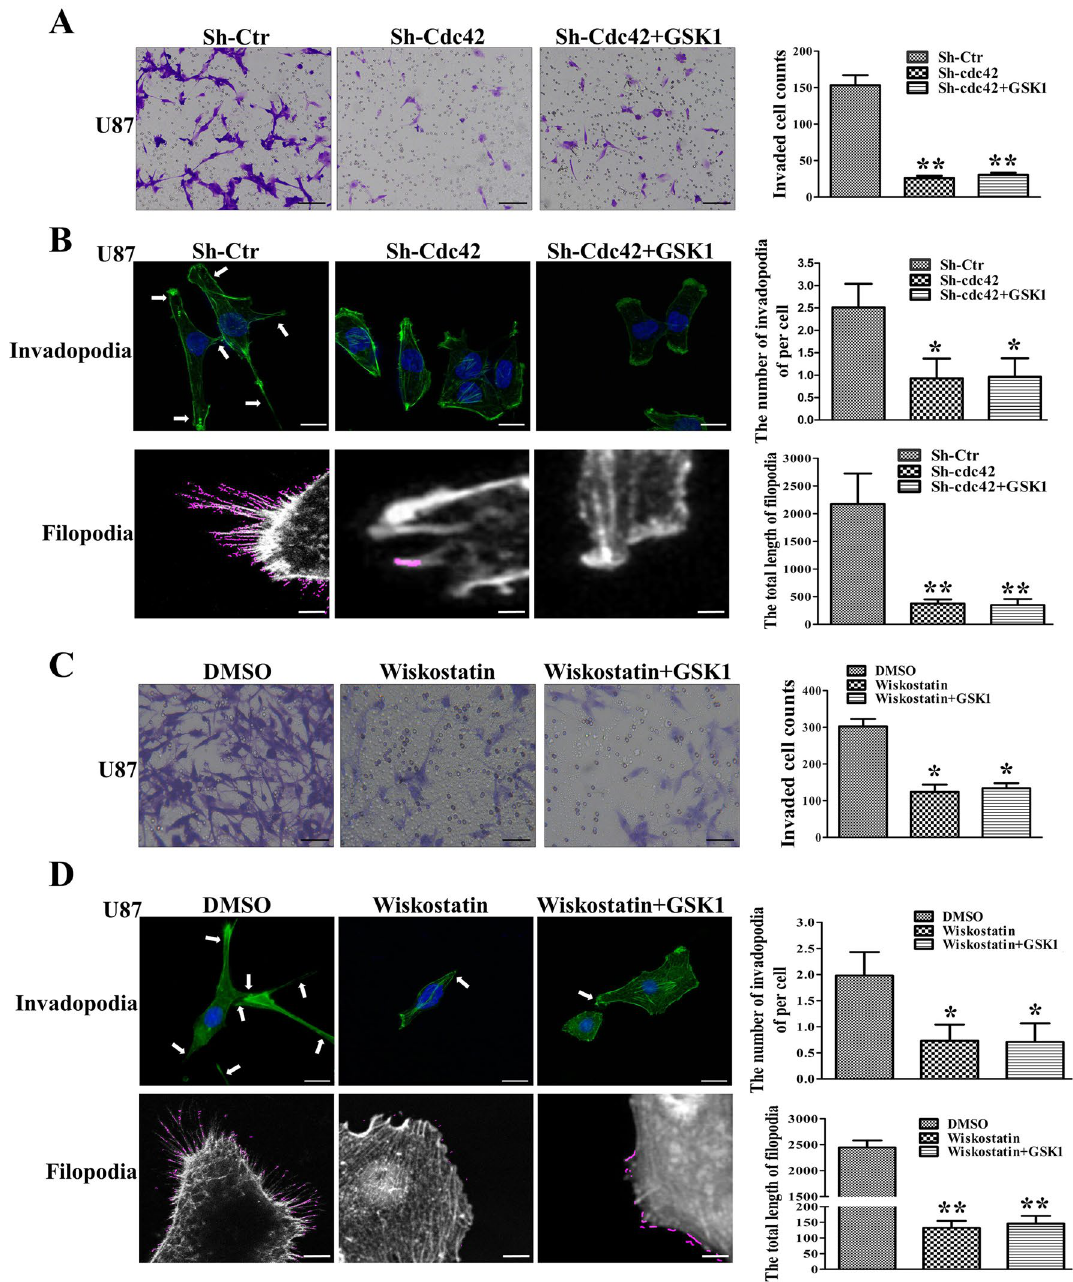
with TRPV4 agonist treatment in U87 cells, scale bar = 100 µm. ( B ) U87 cell invasion ability was detected by Transwell assays after N-wasp inhibitor (wiskostatin, 5 µM) treatment without or with TRPV4 agonist. Scale bar = 100 µm. ( C ) Cellular invadopodia and filopodia changed after Cdc42 down-regulation or combined with TRPV4 agonist treatment in U87 cells. Histograms show the number of invadopodia per cell and the total length of filopodia, Scale bar = 10 µm and 4 µm. ( D ) Cellular protrusions changed after N-wasp repression or combined with GSK1 treatment in U87 cells. Histograms show the number of invadopodia per cell and the total length of filopodia, Scale bar = 10 µm and 4 µm. The Fluorescent images were exported by Zen software and analyzed filopodia by Fiji software. * p < 0.05, ** p <